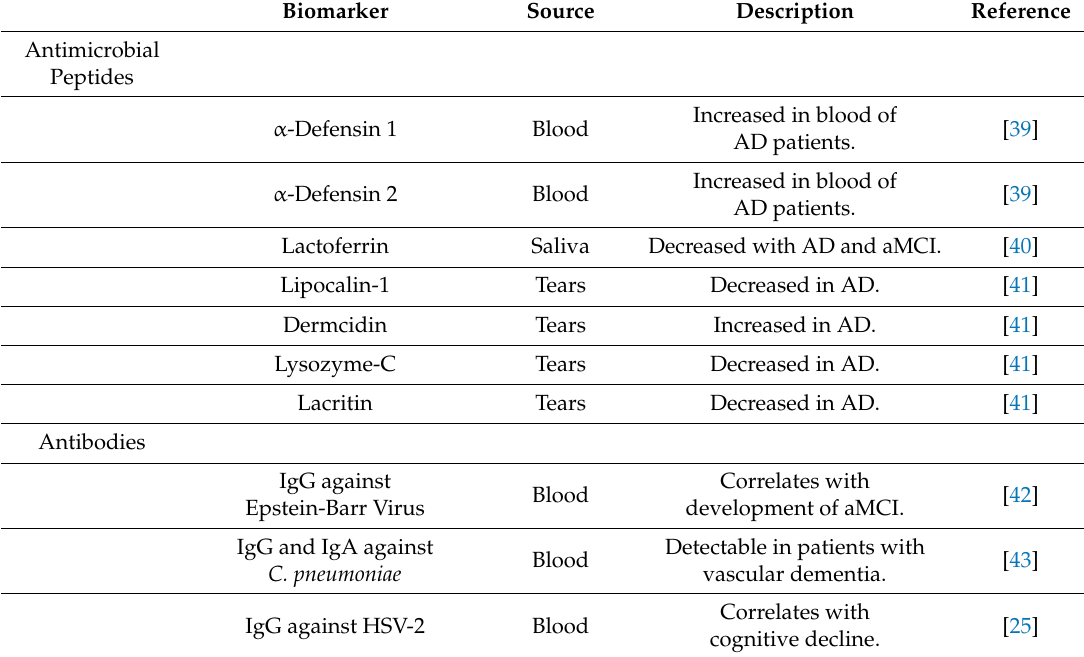
Table 1. Pathogen-Based Biomarkers in AD. Numerous pathogens have been associated with AD pathogenesis and the onset of cognitive decline. Biomarkers are listed along with their source and relationship to